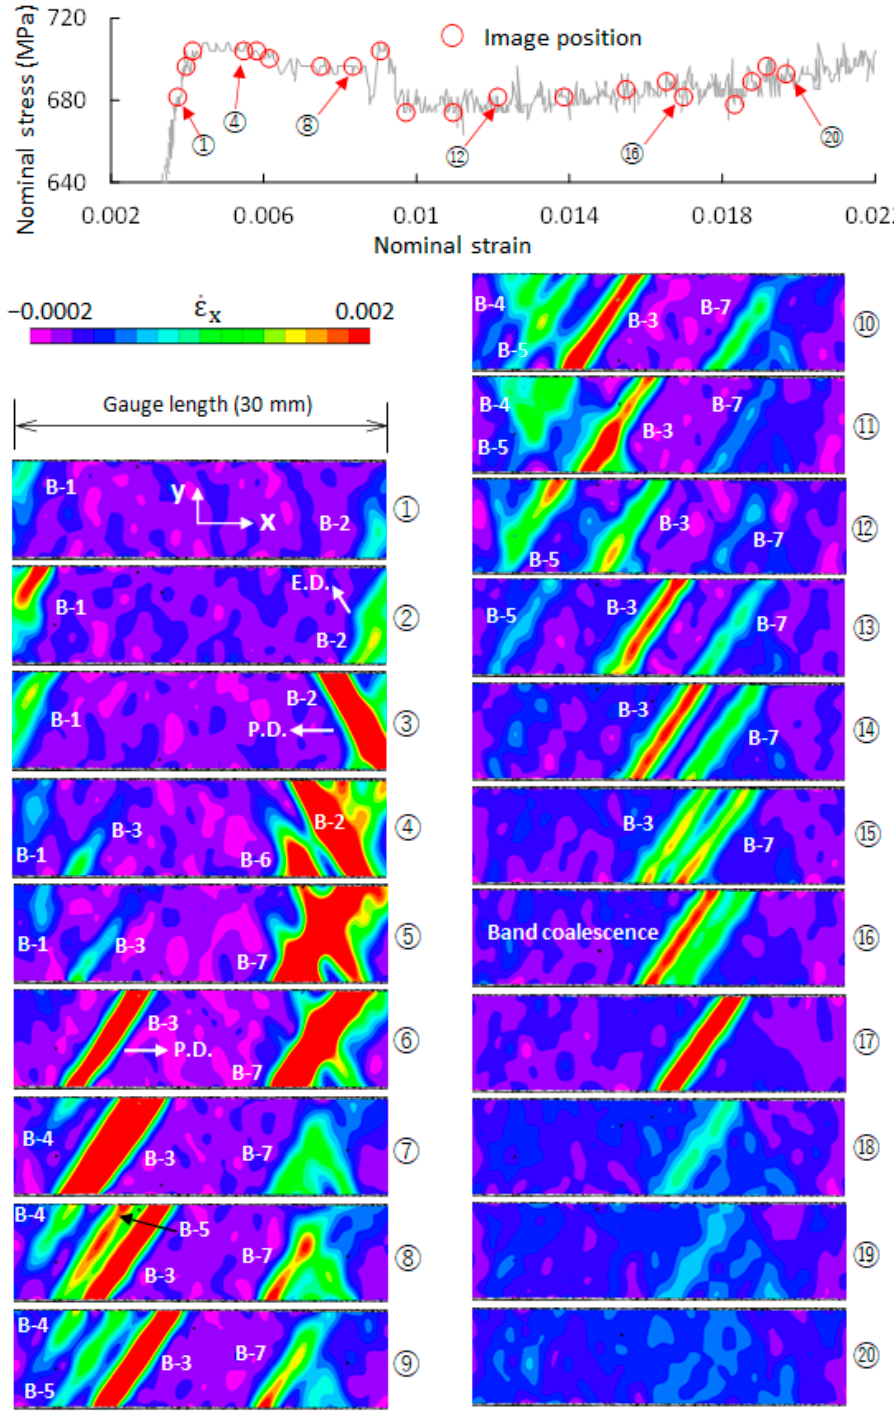
Figure 4. Evolution of plastic bands in tempered martensite steel (QT ‐ 1 specimen). Twenty images ( ① to ⑳ ) on the macroscopic stress–strain curve were taken. Their strain ‐ rate fields over the gauge length (30 mm) show the evolution of plastic bands. B ‐ 1 to B ‐ 7, band 1 to band 7; E. D., extension direction; P. D., propagation direction.